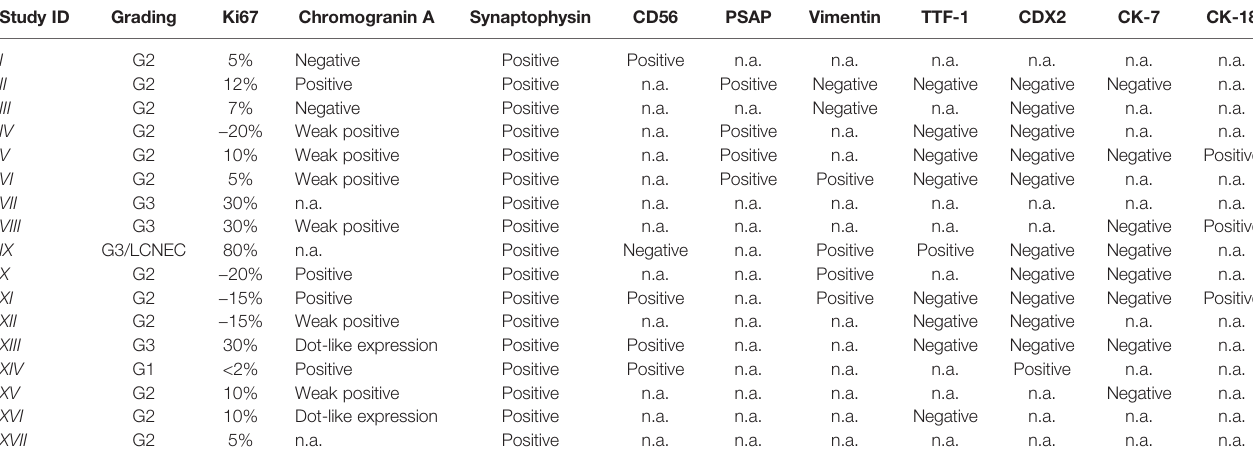
TABLE 2 | Immunohistochemical features of patients with primary presacral neuroendocrine neoplasms. Study ID